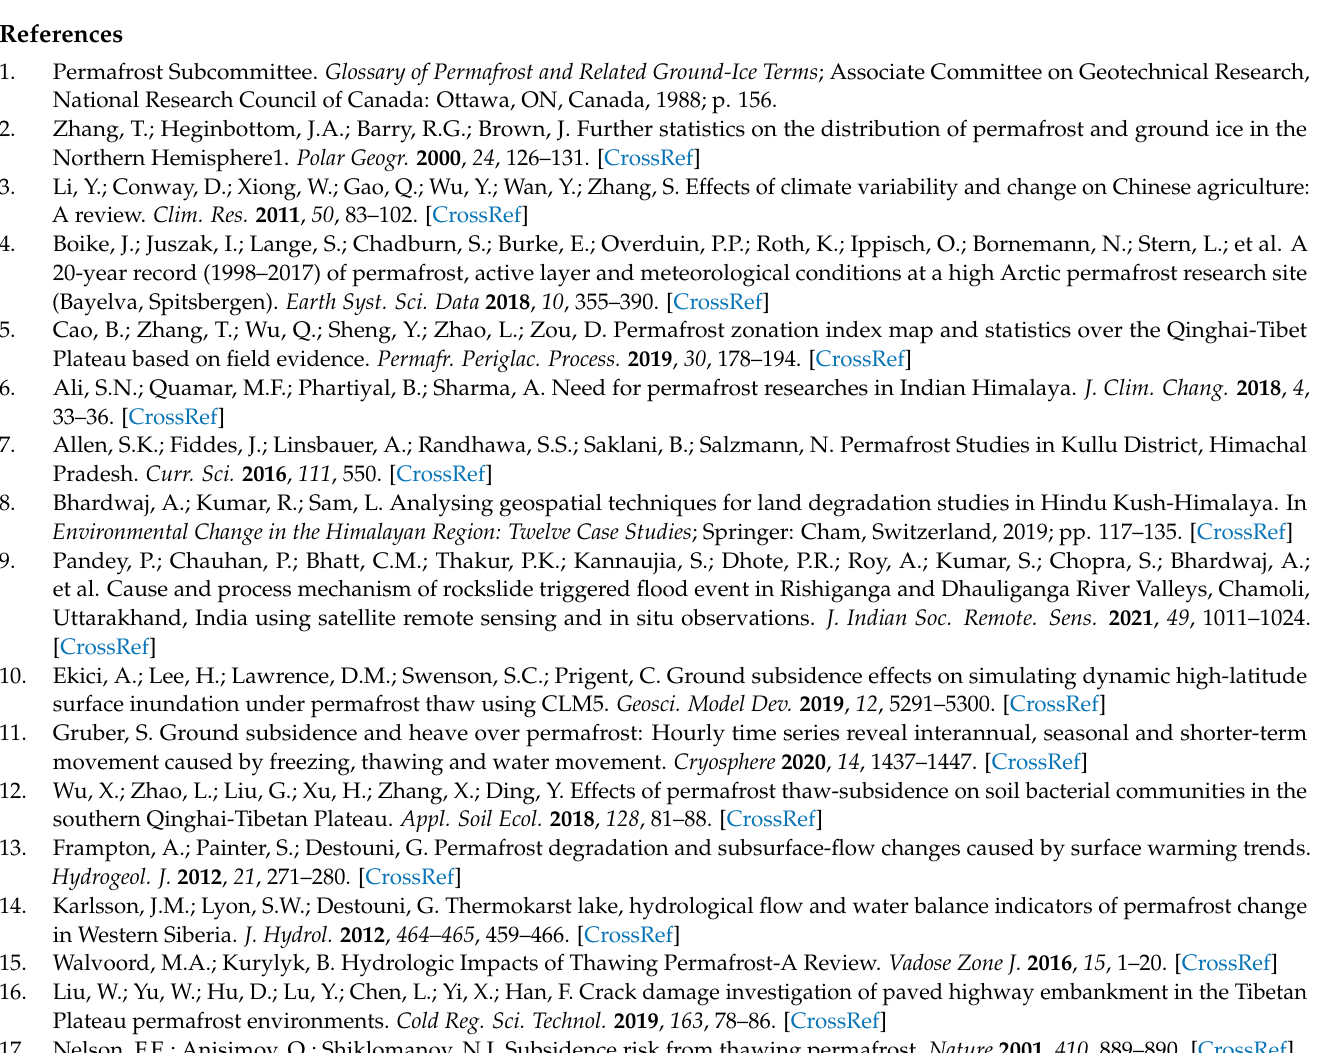
Figure S15: Map of the study area showing the permafrost extent for 2016-18, Figure S16: Map of the study area showing the permafrost extent for 2018-20, Figure S17: Pie charts showing the temporal (2002-04 to 2018-20) variation in the distribution of permafrost extent in the study